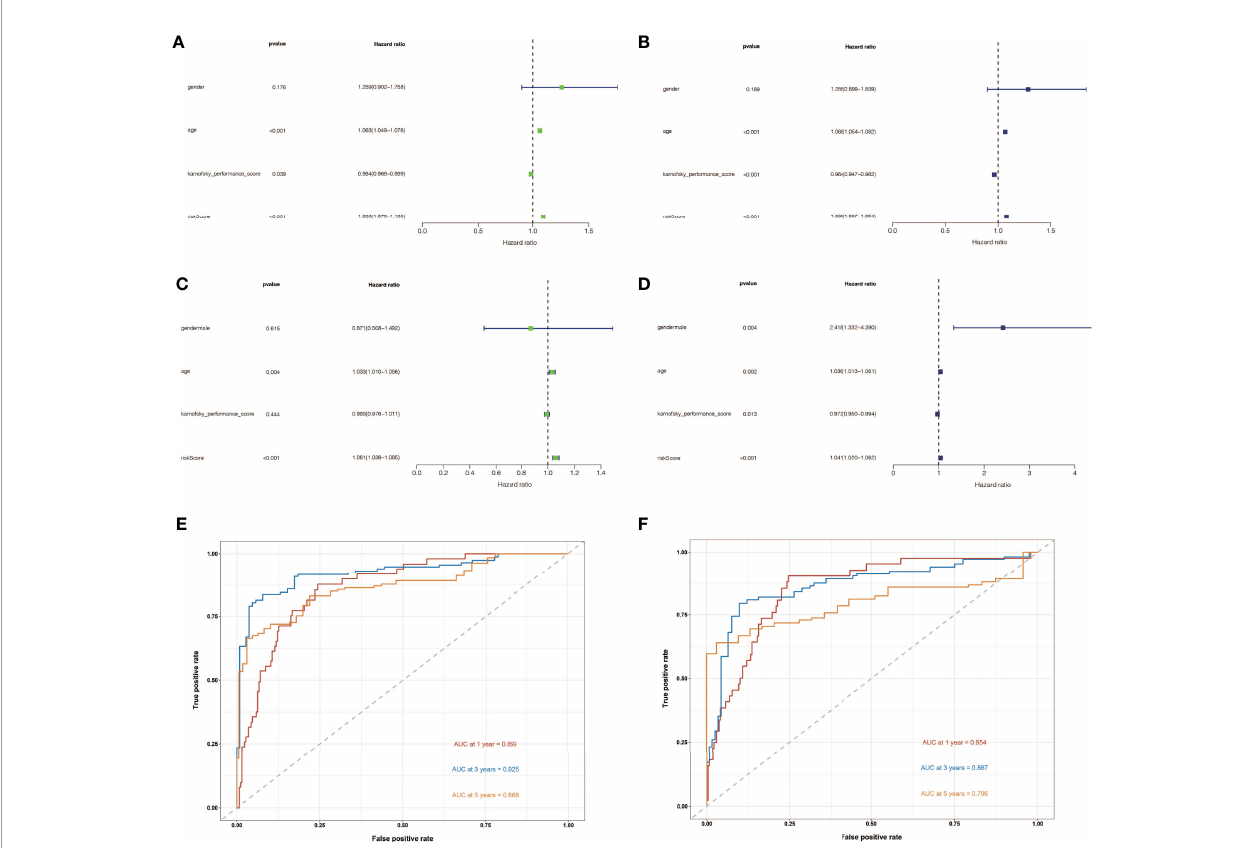
FIGURE 4 | The independent prognostic signi fi cance of risk scores in gliomas was assessed using univariate and multivariate Cox regression. (A) In the training cohort, univariate Cox regression revealed that age and risk score are independent prognostic indicators of glioma. (B) In the validation cohort, univariate Cox regression revealed that age and risk score were independent prognostic indicators of glioma. (C) In the train cohort, multivariate Cox regression revealed that age and risk score were independent prognostic markers of glioma. (D) Multivariate Cox regression revealed that gender, age, and risk score were independent prognostic indicators of glioma in validation cohort study. (E) Training cohort ’ s ROC curve. The AUC for 1, 3, and 5 years was 0.869, 0.925, and 0.868, respectively. (F) ROC curve for validation cohort showed that the AUC of 1, 3 and 5 years were 0.854, 0.867 and 0.796,